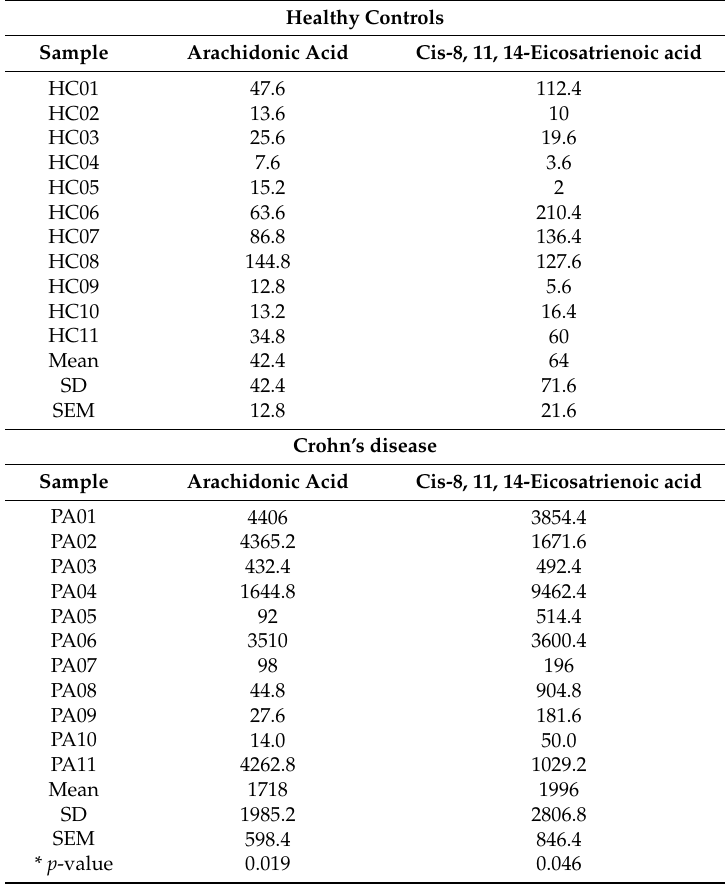
Table 5. Concentration of fatty acids in each sample ( µ g/g of dry